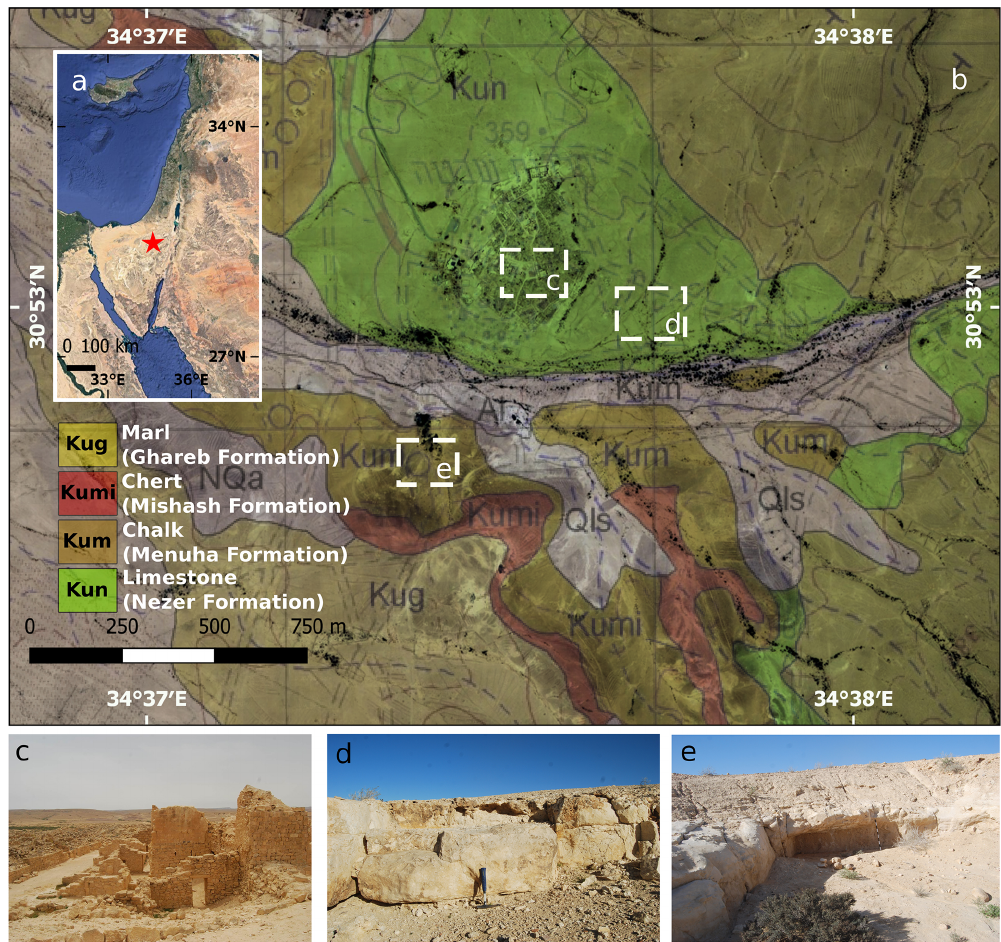
Figure 1. (a) Geographical location of the study area (red star) in the central Negev, Israel (Google, © 2020 Landsat/Copernicus Data SIO, NOAA, U.S. Navy, NGA, GEBCO, Mapa GISrael); (b) Shivta geological map (Sneh et al., 2011; reproduced with permission); (c) a panoramic view of the Byzantine city of Shivta; (d) ancient limestone quarry located in the vicinity of Shivta (30cm hammer for scale); (e) ancient chalk quarry located in the vicinity of Shivta (1m black-and-white stick for scale).